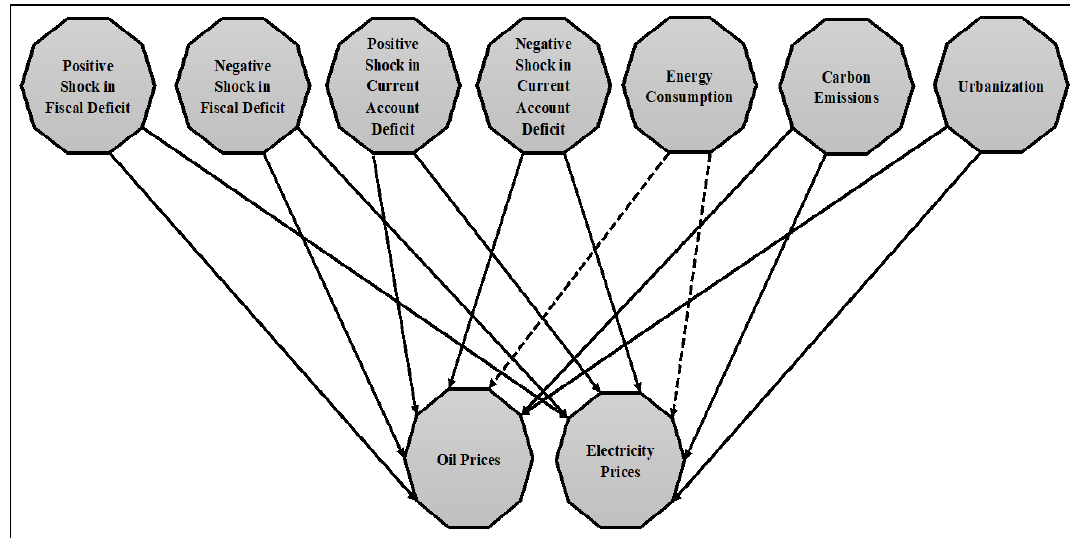
Figure 6. Graphical representation of long-run results of Model 3 and Model 4. Note: Dotted and Continuous lines represent negative and positive impact of the variables, respectively. Source: Authors’ compilation.